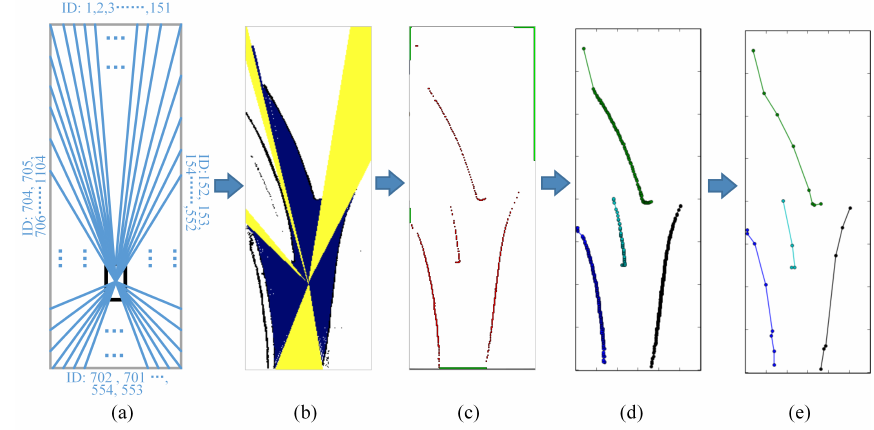
Figure 4. Road boundary vectorization and simplification. ( a ) initially generated virtual scans. ( b ) road boundary candidate calculation (blue and yellow represent hit and miss, respectively). ( c ) road boundary candidate clustering (red denotes road boundaries and green denotes free spaces). ( d ) road boundary vectorization. ( e ) road boundary